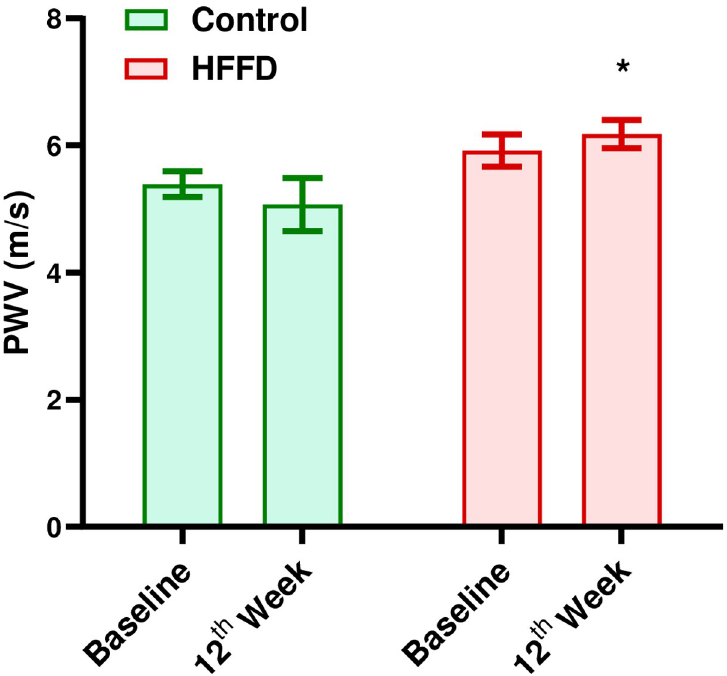
Fig 5. Effect of 12 weeks of HFFD feeding on arterial stiffness. The PWV was measured at the beginning and end of the protocol in order to assess the arterial vascular elasticity. It was calculated using the following formula: PWV (m/s) = Δ x/ Δ t. Data are expressed as mean ± SEM. Repeated measures two-way Anova test was used for statistical analysis. n = 9 for control, n = 12 for HFFD. � p < 0.05 vs. Control.